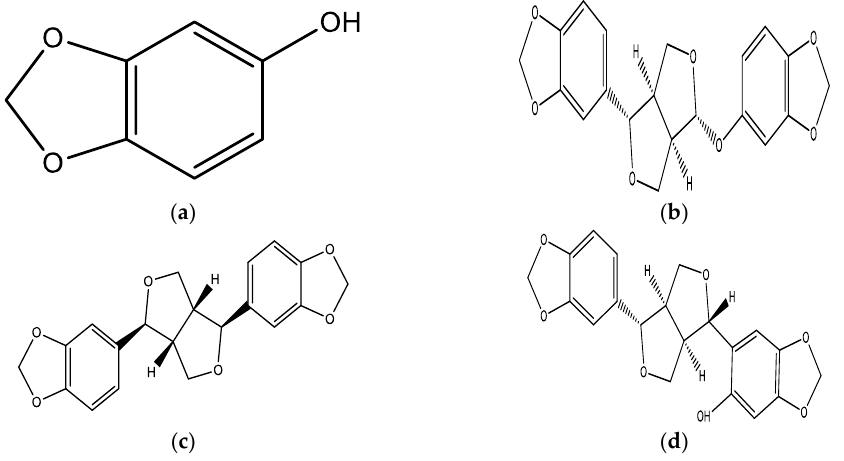
Figure 1. Chemical structure of ( a ) sesamol, ( b ) sesamolin, ( c ) sesamin, and ( d ) sesaminols.